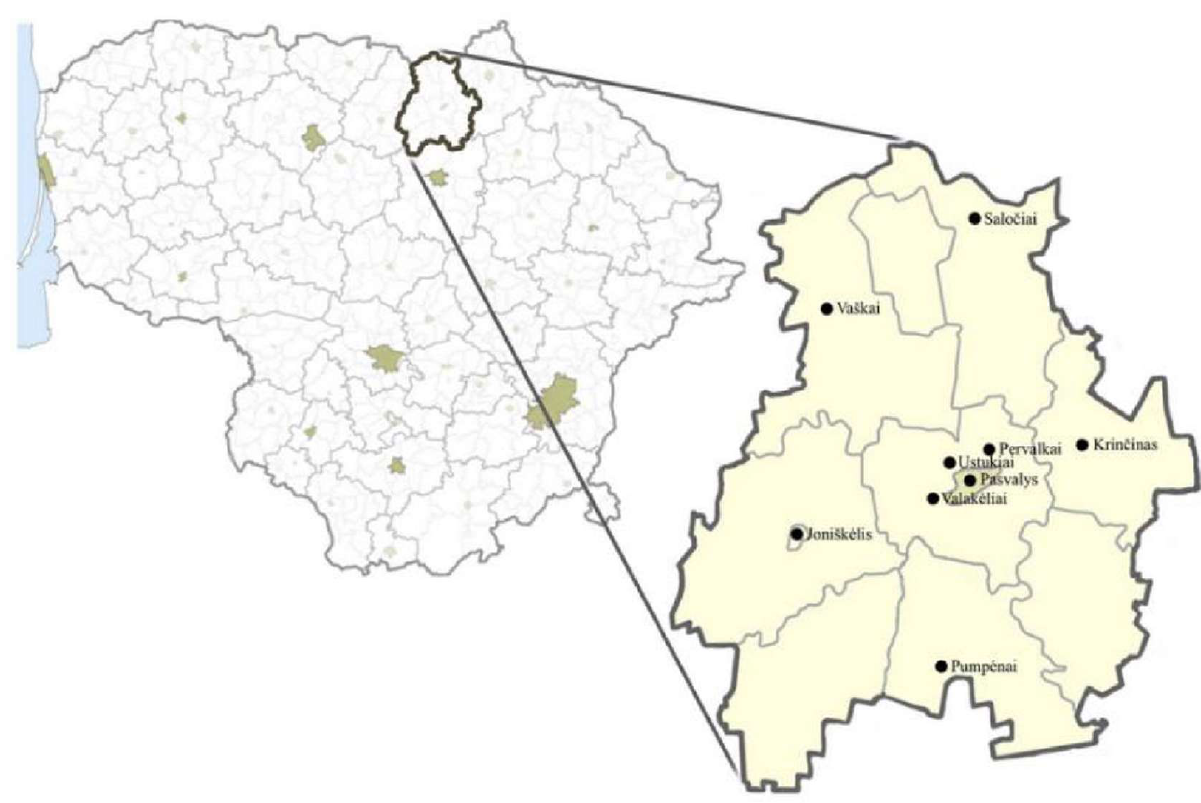
Figure 1. The study area.